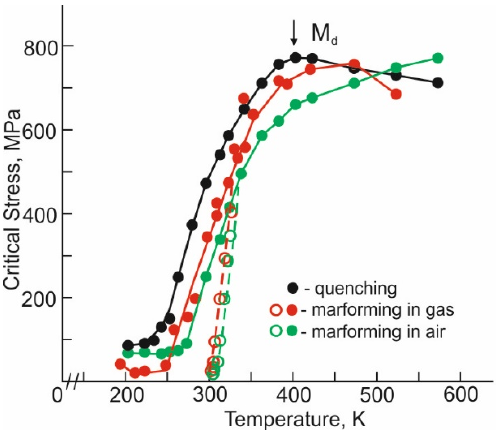
Figure 7. Temperature dependence of critical stresses of the [011]-oriented Ti-50.1Ni single crystals under compression. The open circles represent data from the SME studies.